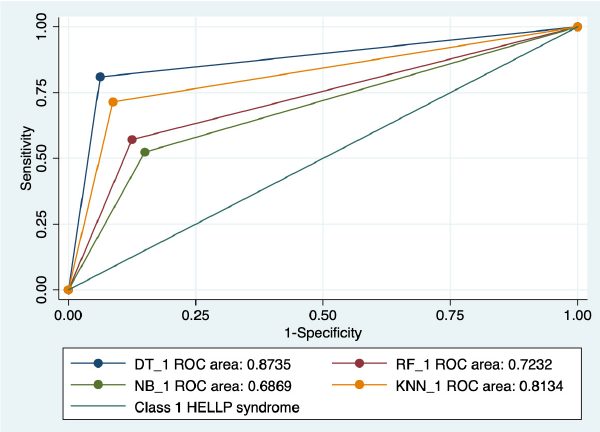
Figure 6. Multiple ROC curves comparison between different machine learning models for class 1 HELLP syndrome. Legend: ROC—Receiver operating characteristic; DT—decision trees; NB—na- ïve Bayes; KNN—k-nearest neighbors; RF—random forest.